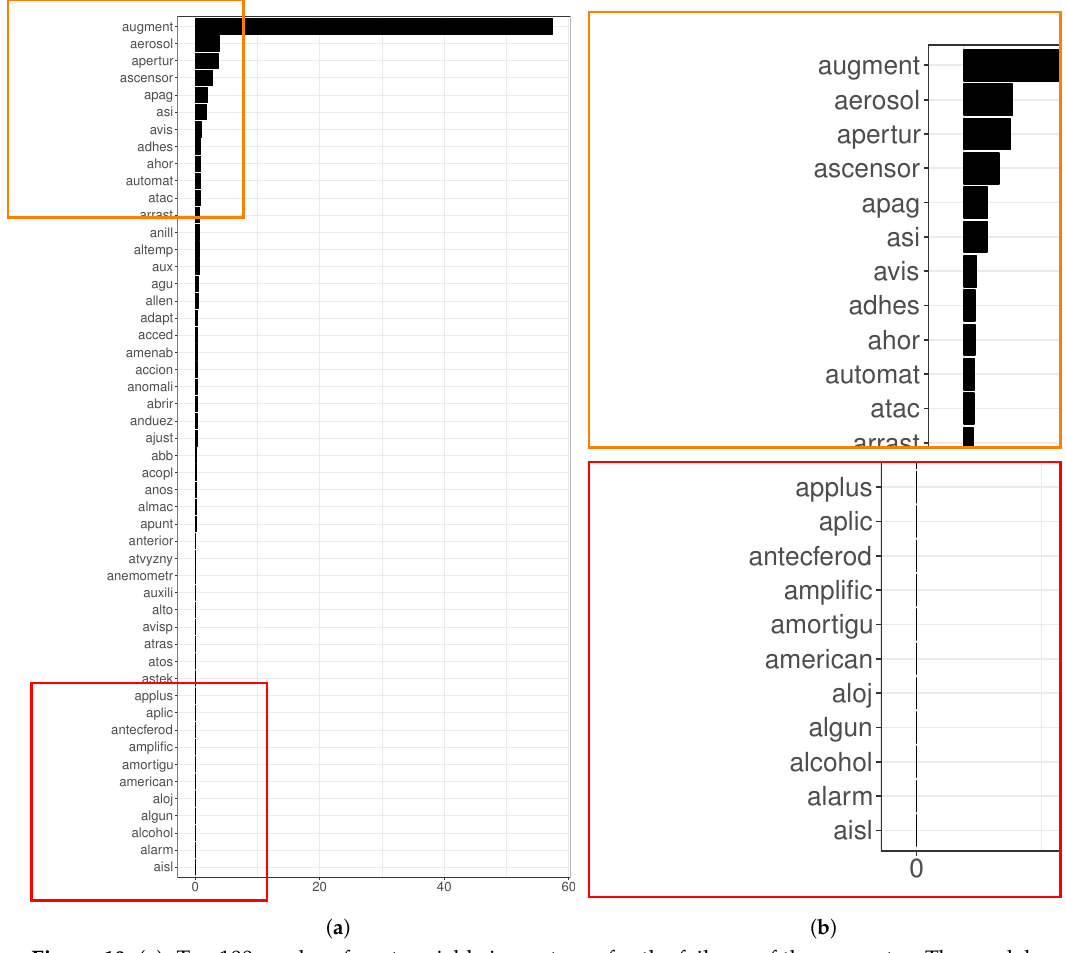
Figure 10. ( a ): Top 100 random forest variable importance for the failures of the generator. The model was generated with words that have a frequency from 1% to 10%. This range is a good trade-off according to the metrics of Figure 9. The top most and less important words can be seen in panel ( b ), delimited by an orange and a red square, respectively. The RF model selected the word augment, which is the root of the word augmentar (to increase), as the most important